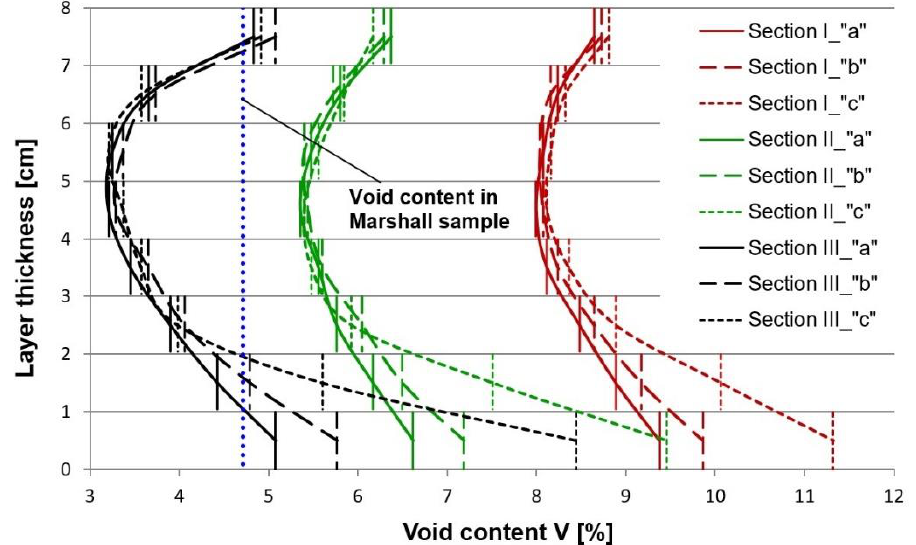
Figure 7. Air void content (V m ) in the 8 cm thick binder course, determined on the sliced specimens, depending on the number of passes of the compactor roller. The designations of the sections (I, II, and III) and the test zones of different moisture content (a, b, and c) are the same as used in Figure 3.